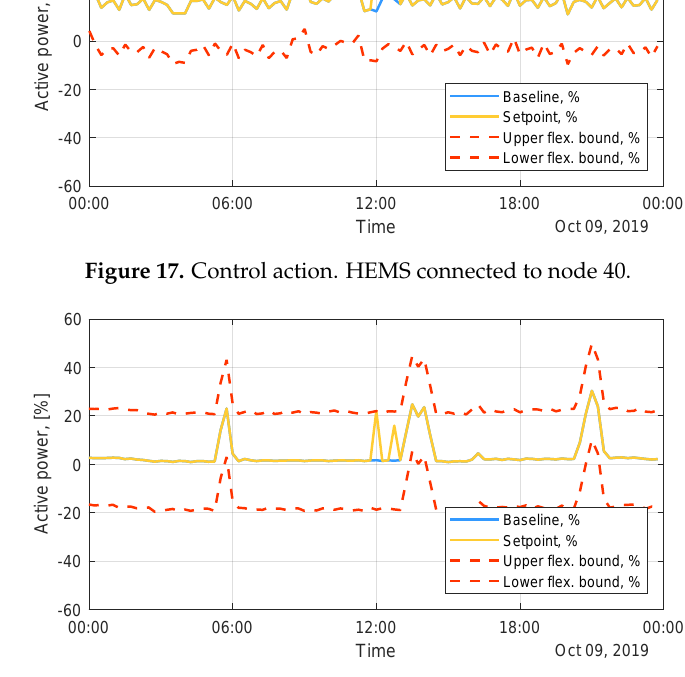
Figure 18. Control action. HEMS connected to node